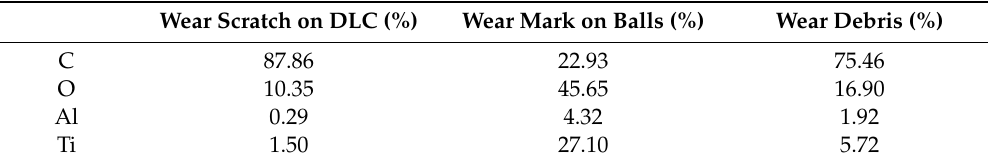
Table 2. Element contents on the friction interfaces.